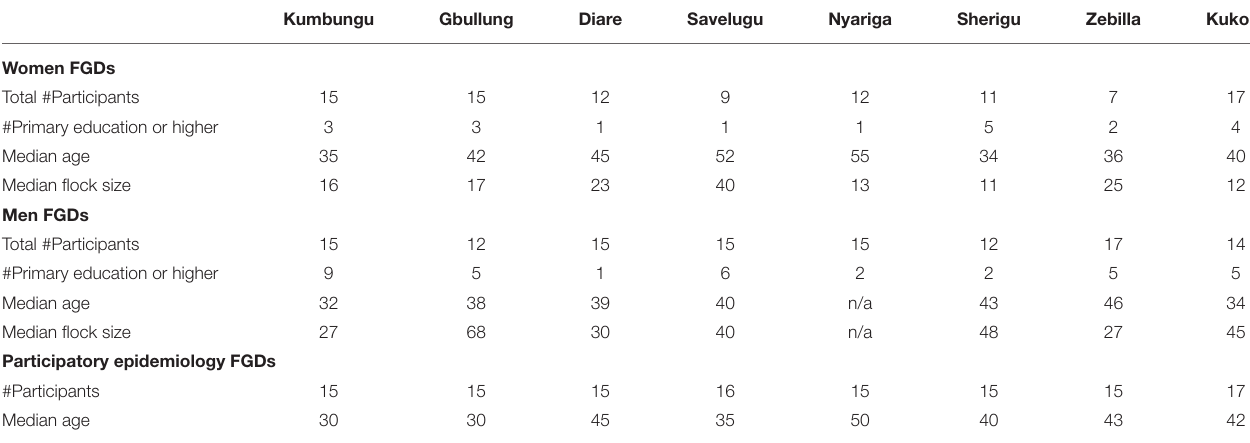
* Data presented are for farmer-focused groups only. Data from mixed occupation value chain FGDs are not included. Data on median flock size is missing for the mixed farmer groups in Ghana. Source: Field work.